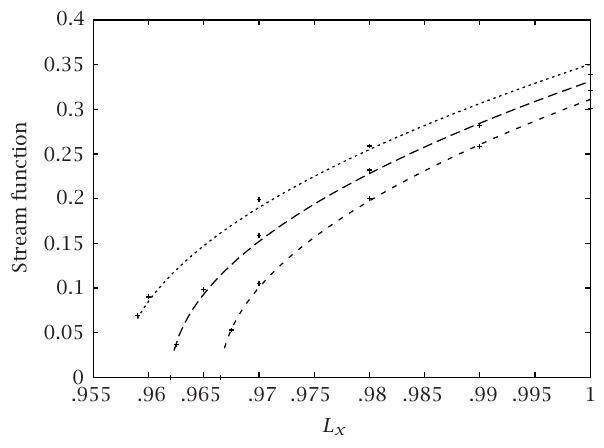
Figure 5.3 . Maximum of the stream function as a function of the width of the domain for different Z . Dots: simulations, curves: approximation by the square-root formula. Lower curve: Z = 7 . 8, intermediate curve: Z = 7 . 9, and upper curve: Z = 8 .